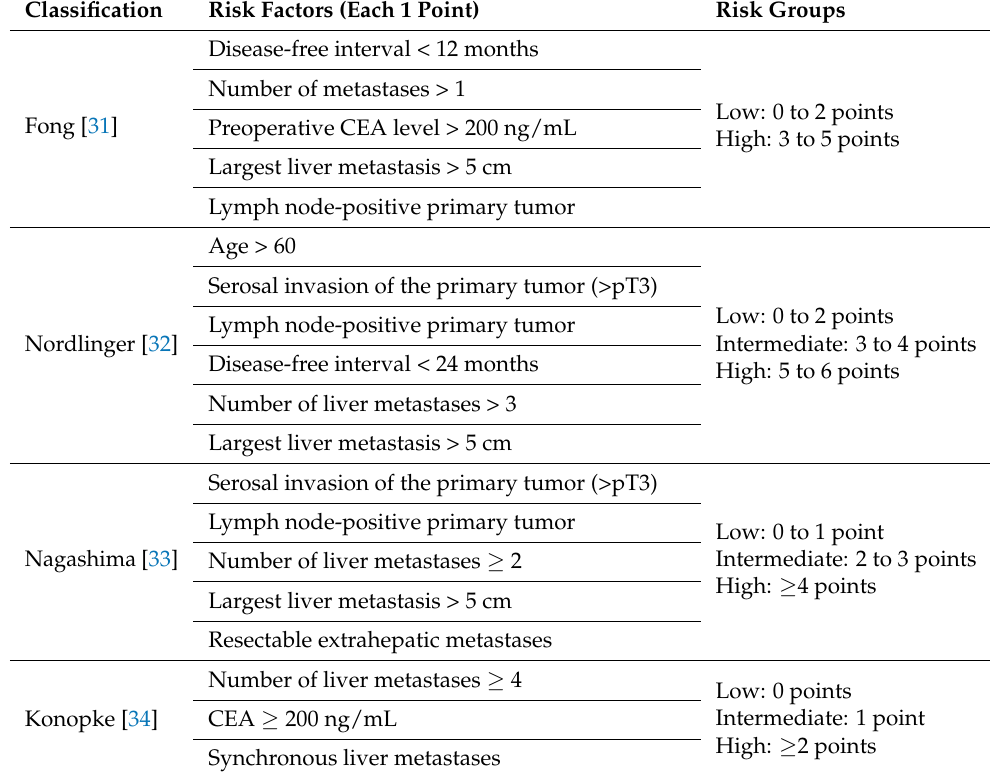
Table 2. Risk of recurrence based on risk